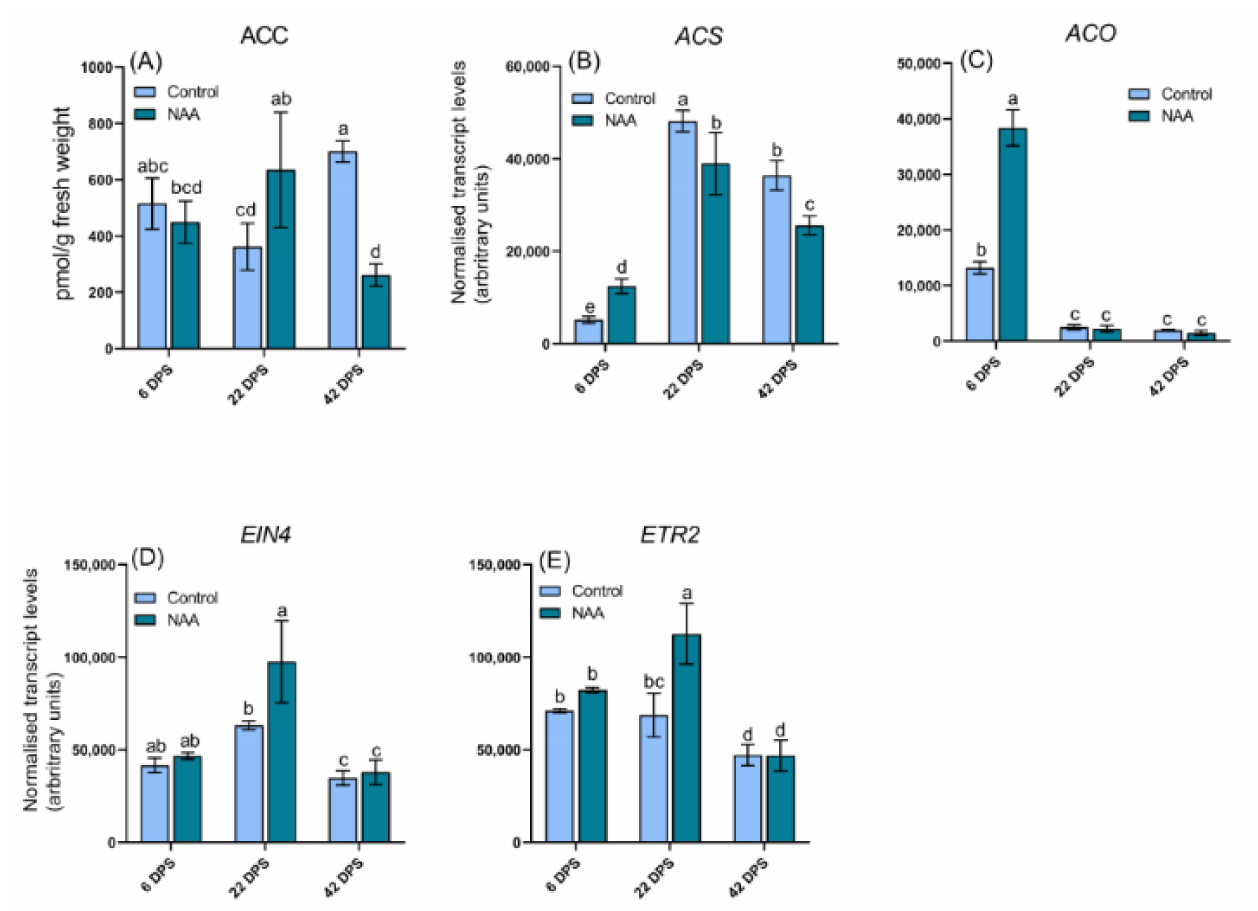
Figure 4. LC-MS/MS analysis of 1-aminocyclyopropane-1-carboxylic acid (ACC) concentrations in sweet cherry ( Prunus avium L.) fruit at three timepoints after the pre-ripening application of 100 mg/L NAA ( A ) ACC p = 0.0021. Additionally, shown is qRT-PCR data of ethylene biosynthetic and receptor genes ( B ) ACS p <0.0001, ( C ) ACO p <0.0001, ( D ) EIN4 p < 0.0001 and ( E ) ETR2 p < 0.0001. All data represent means ± s. e. ( n = 3), bars are denoted by a different letter (a, b, c, d, e, ab, bc, cd, abc, bcd) if the means differ significantly using one-way ANOVA followed by Waller-Duncan’s post hoc test. DPS = days post